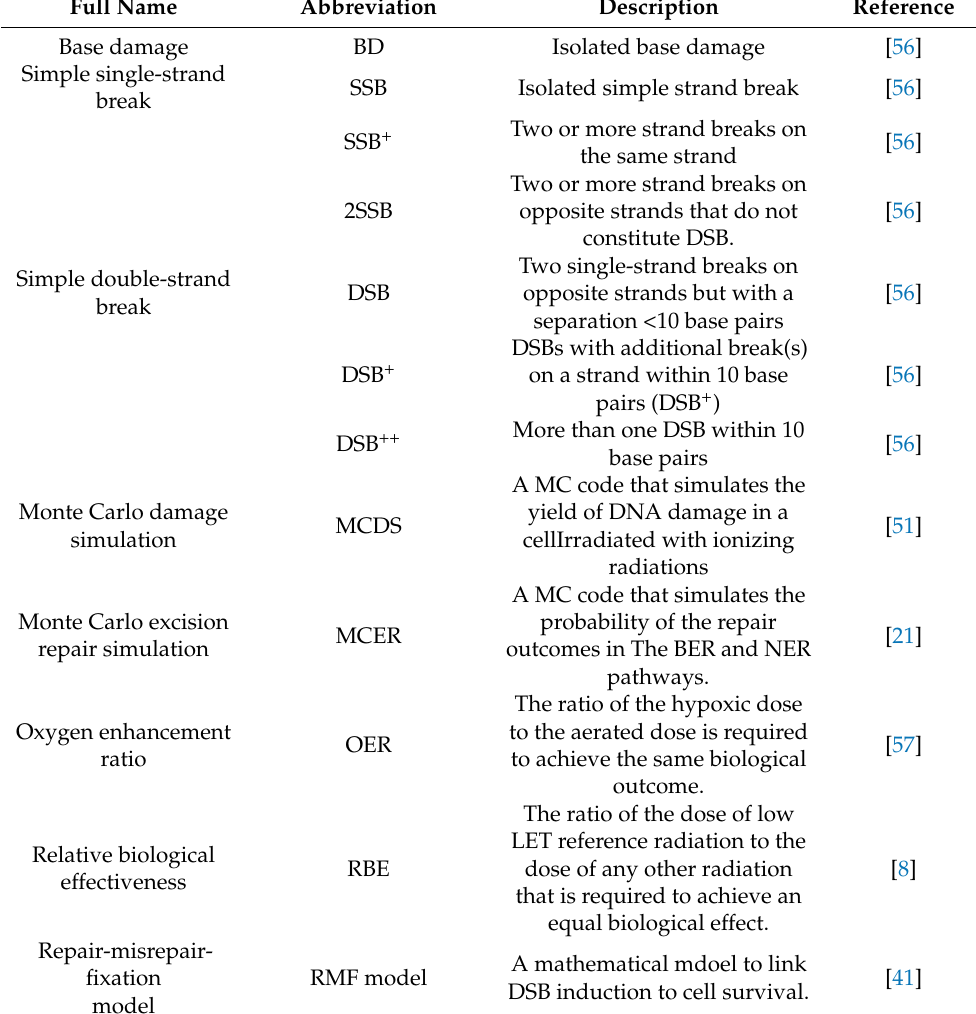
Table 1. Description of abbreviations used in this